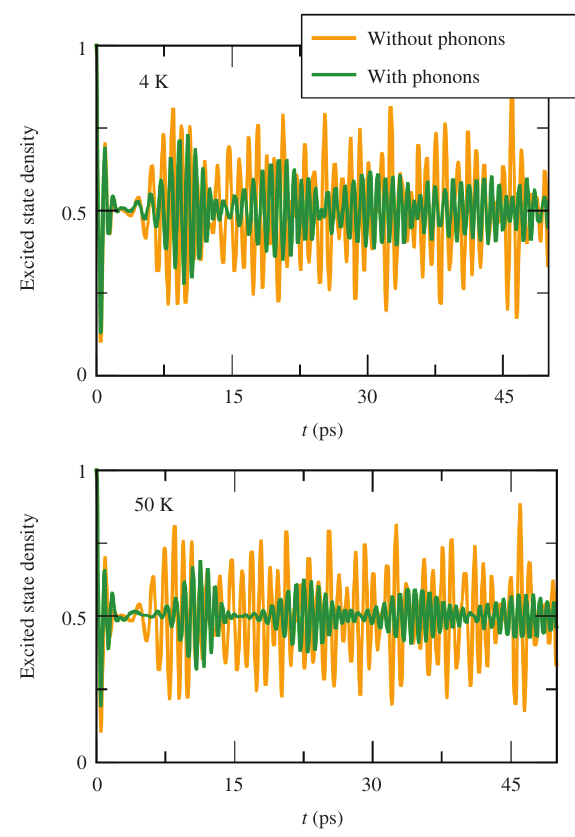
( t )〉 for a cavity initialized 22